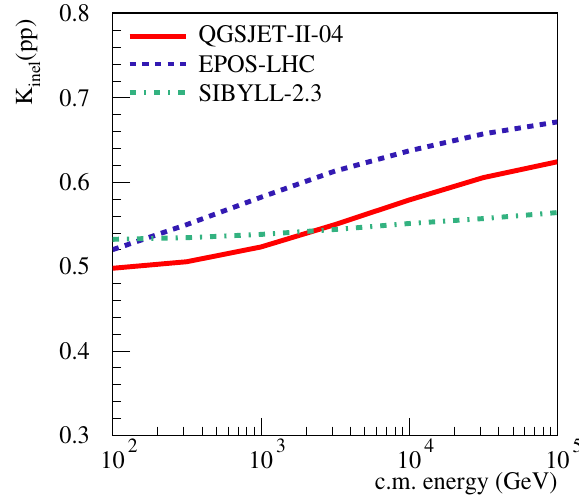
Figure 3. Energy dependence of the inelasticity of leading nucleons in pp collisions, as calculated using the QGSJET-II- 04, EPOS-LHC, and SIBYLL-2.3 models (solid, dashed, and dashed-dotted lines respectively).